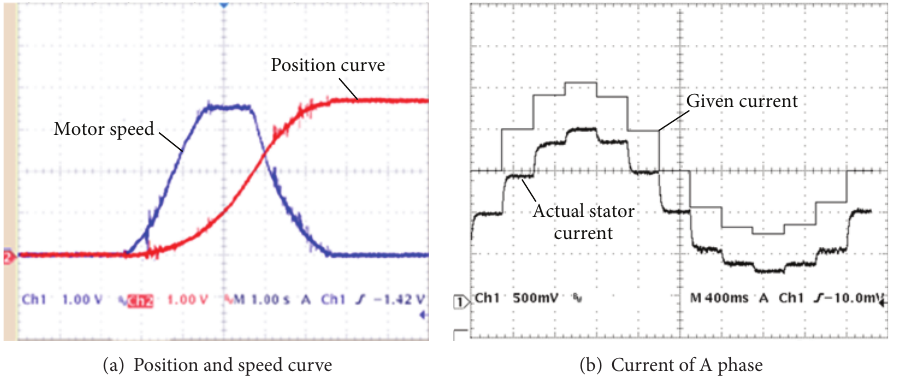
Figure 16: Experiment curve of up-down frequency